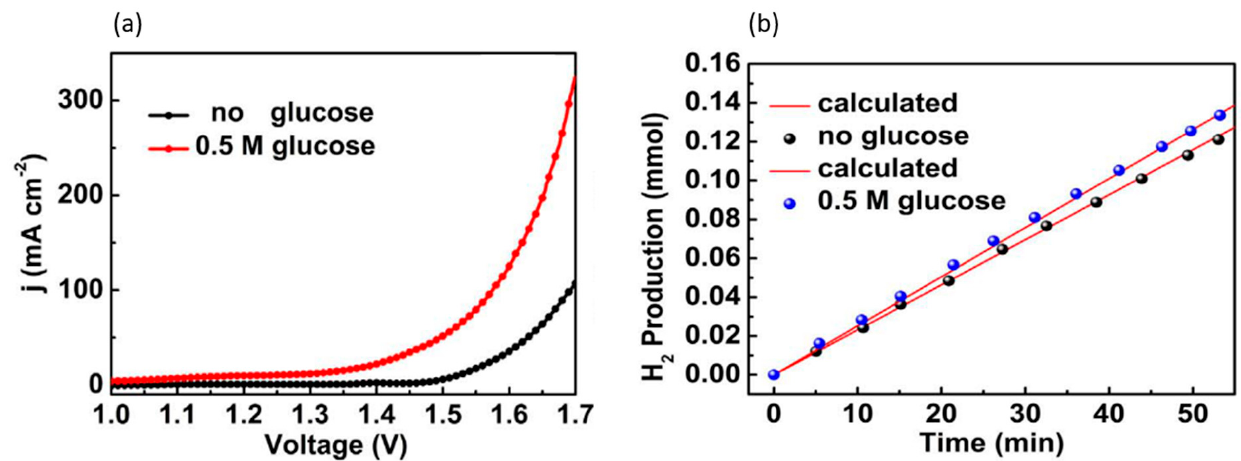
Figure 21. ( a ) LSV scan in 2-electrode cell without and with 0.5 M glucose in 10 M KOH, iron phosphide anode. ( b ) Amount of hydrogen theoretically calculated and collected at 1.9 V, 10 M KOH with and without 0.5 M glucose. Reprinted with permission from Ref [109]. Copyright 2017, Electrochemistry Communications.